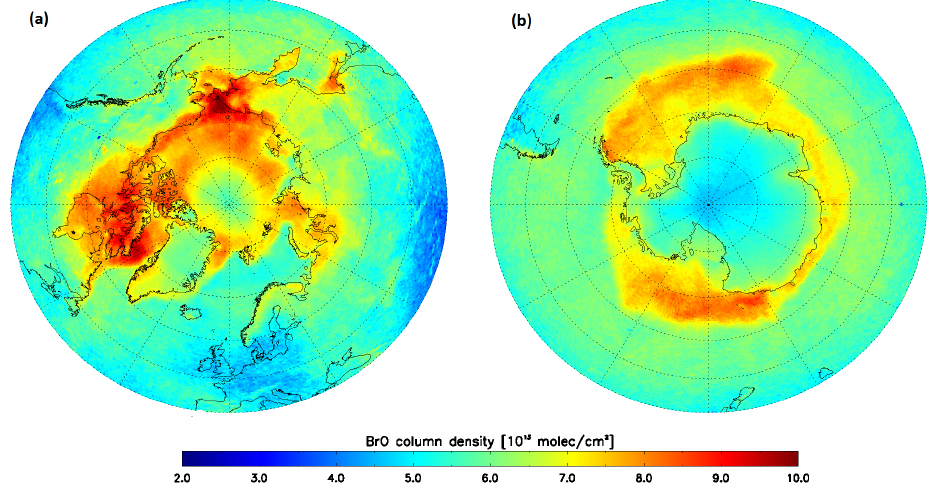
Figure 14. Monthly averaged total BrO columns (a) over the Arctic, April 2007 and (b) Antarctic, October 2007.